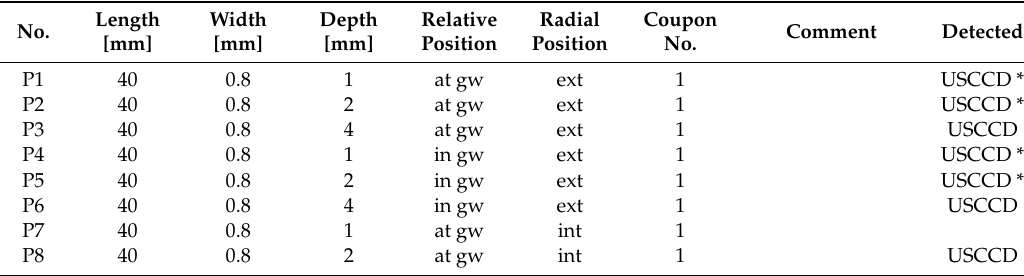
Table A1. Parameters of defects with detected